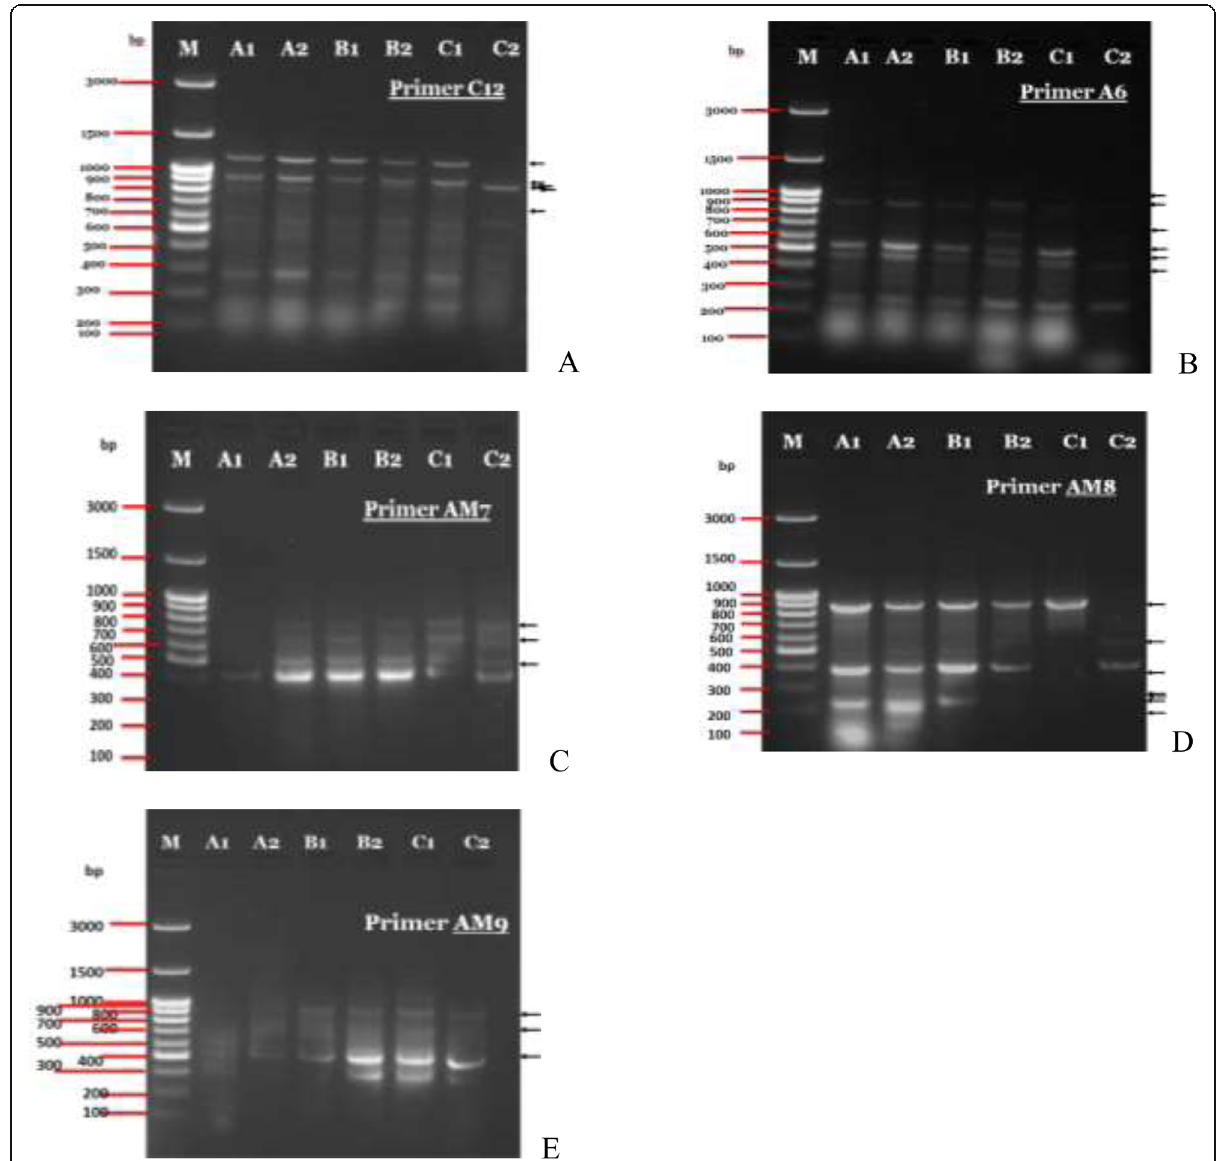
Fig. 3 Agarose gel electrophoresis of randomly primed DNA amplification (RAPD) fragments. Lanes A1 and A2 refer to mother plants, lanes B1 and B2 refer to in vitro propagated plants, lanes C1 and C2 refer to in vitro plants regenerated from callus, and lane M indicates molecular weight DNA ladder given in bp (100 – 3000). Polymorphic DNA fragments are identified by an